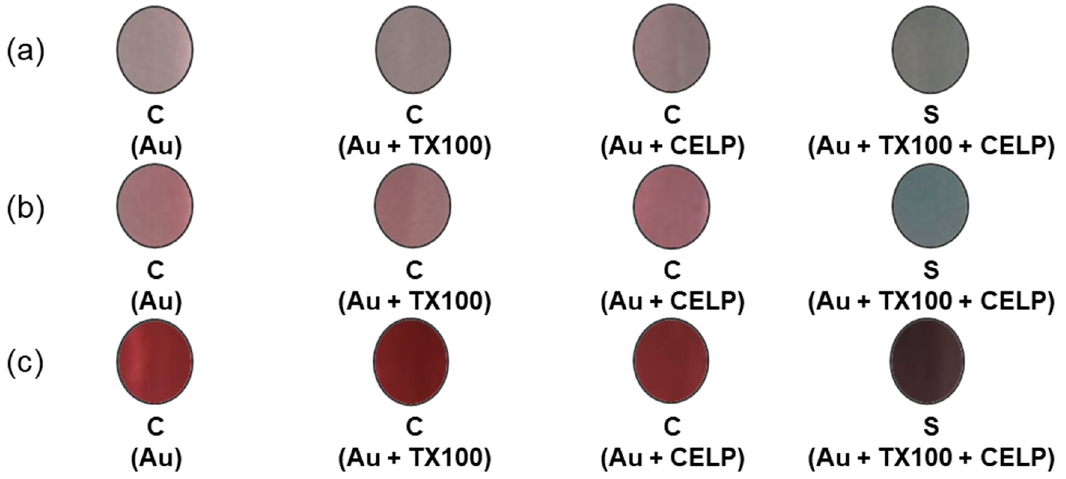
Figure 3. Colorimetric responses of AuNPs at different concentrations: ( a ) 0.06 mM, ( b ), 0.12 mM, ( c ) 0.24 mM.